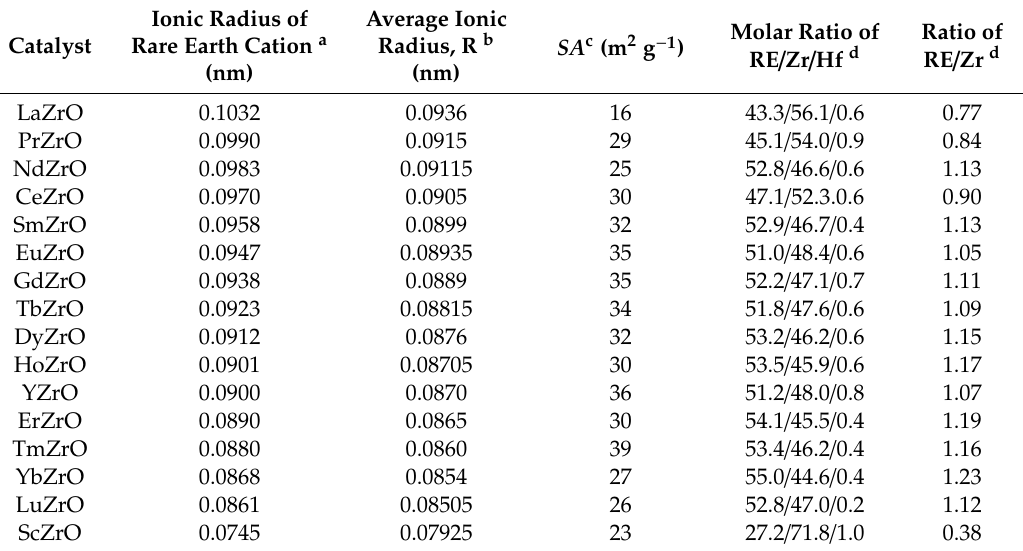
Table 1. Properties of REZrO catalysts calcined at 900 ◦